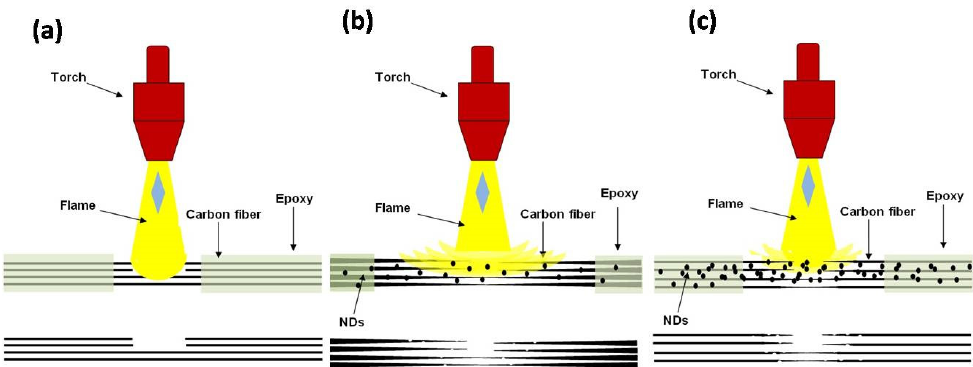
Figure 16. Mechanism of ablation: ( a ) CF–epoxy composites without NDs, ( b ) CF–epoxy composites containing 0.2 wt% NDs, and ( c ) CF–epoxy composites comprising 0.4 wt% NDs.